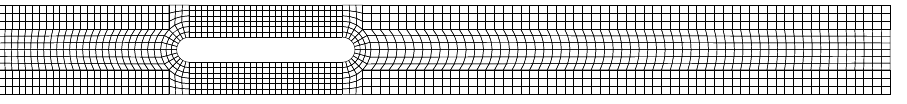
Figure 2. An example of a computational grid created with the utilities blockMesh and mirrorMesh for a mesh spacing of 2